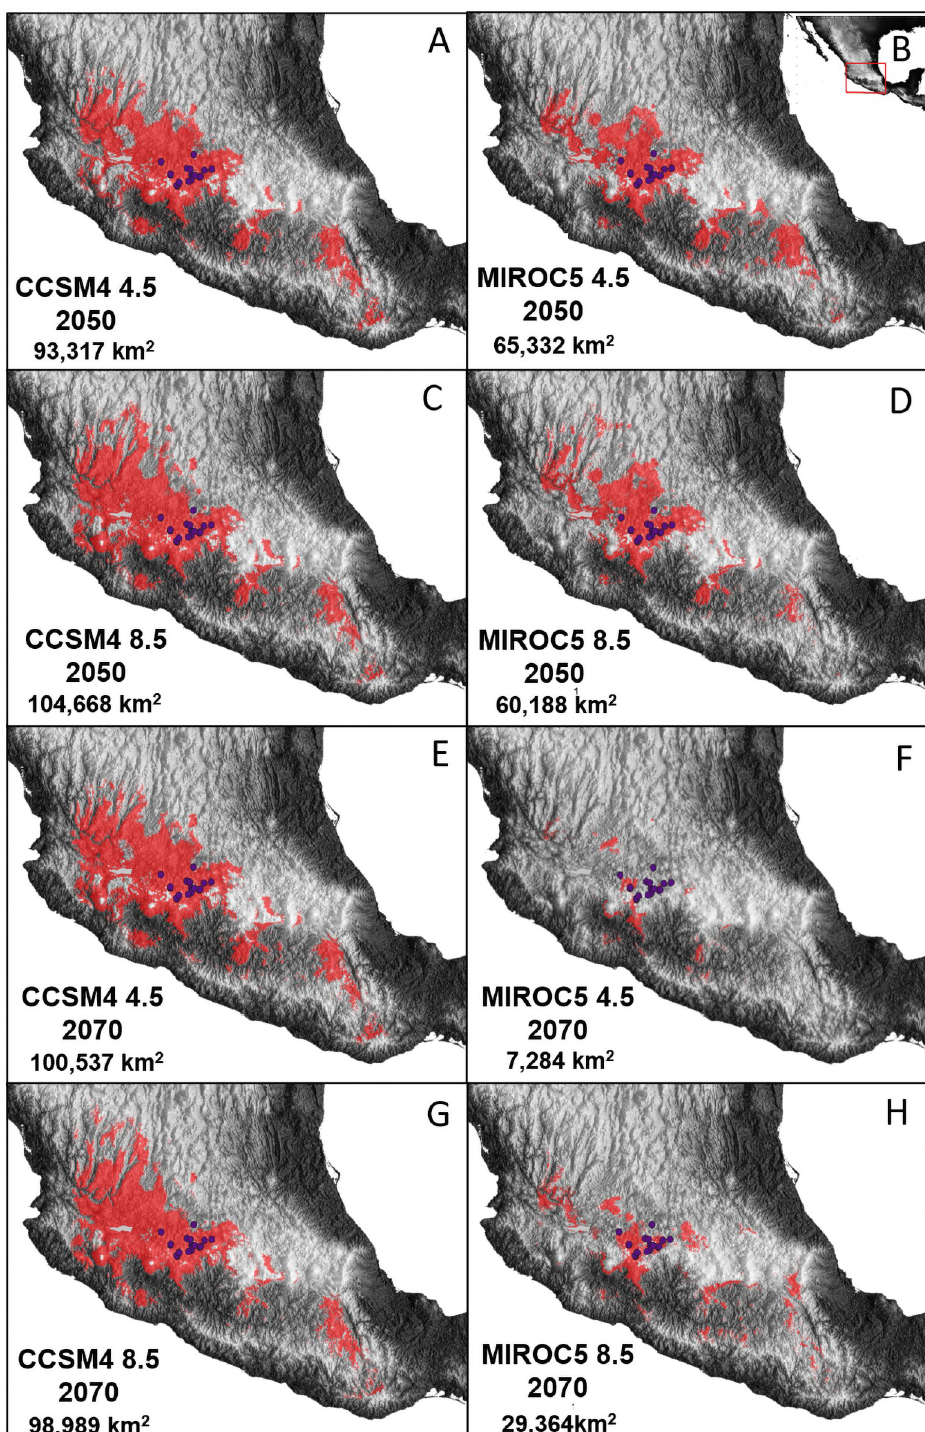
Fig 5. Ecological niche predictions of the overlap niche zone among Bursera bipinnata , B . cuneata , and B . palmeri for future climatic scenarios: (A) 2050 optimistic scenario (RCP 4.5, CCSM4), (B) 2050 optimistic scenario (RCP 4.5, MIROC), (C) 2050 pessimistic scenario (RCP 8.5, CCSM4), (D) 2050 pessimistic scenario (RCP 8.5, MIROC), (E) 2070 optimistic scenario (RCP 4.5, MIROC), (F) 2070 pessimistic scenario (RCP 8.5, CCSM4), (G) 2070 pessimistic scenario (RCP 8.5, CCSM4), (H) 2070 pessimistic scenario (RCP 8.5, MIROC). Red areas on the map indicate the predicted overlap niche zones, purple dots represent the occurrence of hybrid populations, and numbers in km represent the total extension of the hybrid zone.